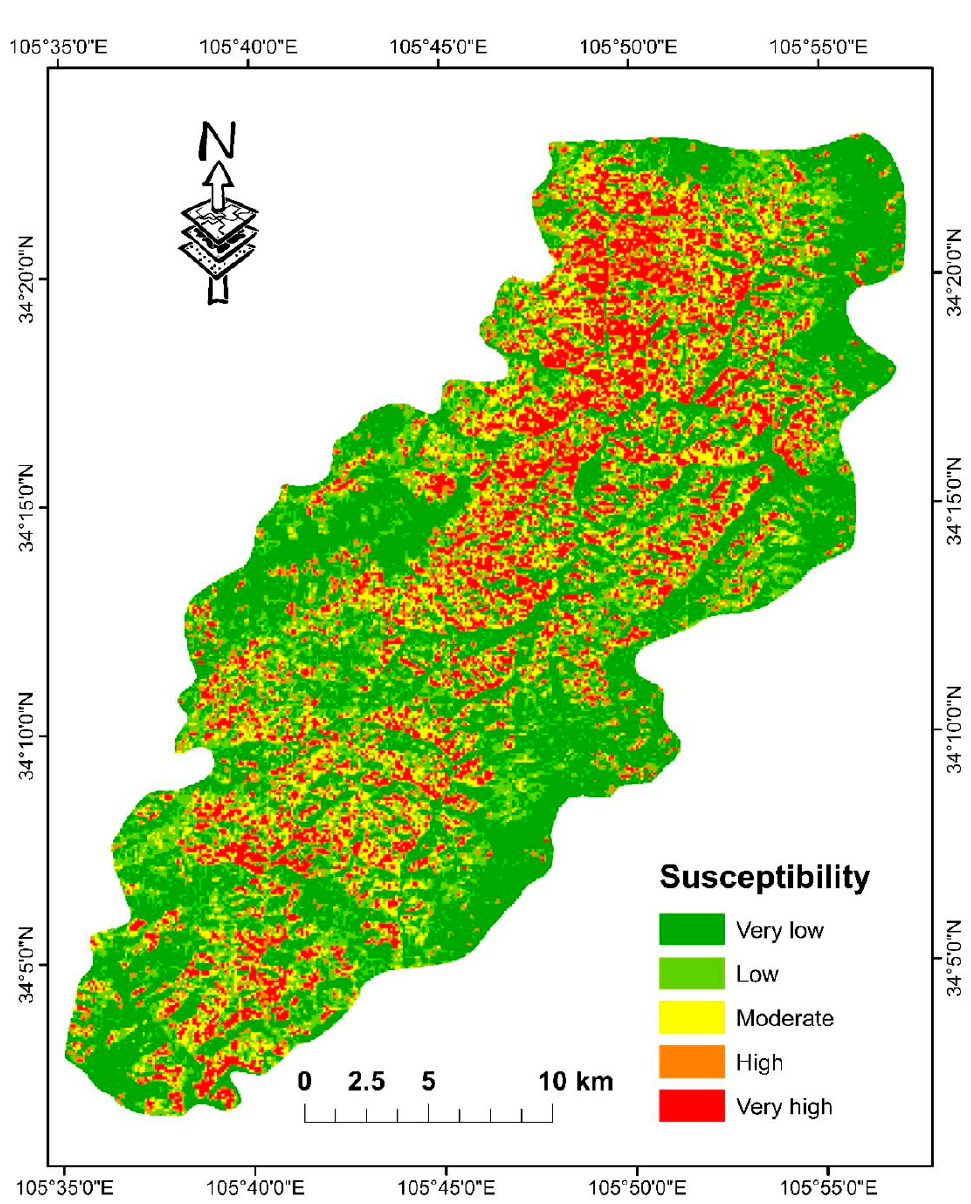
Figure 11. Landslide susceptibility map of the Tianshui area calculated using the RandomForest model.